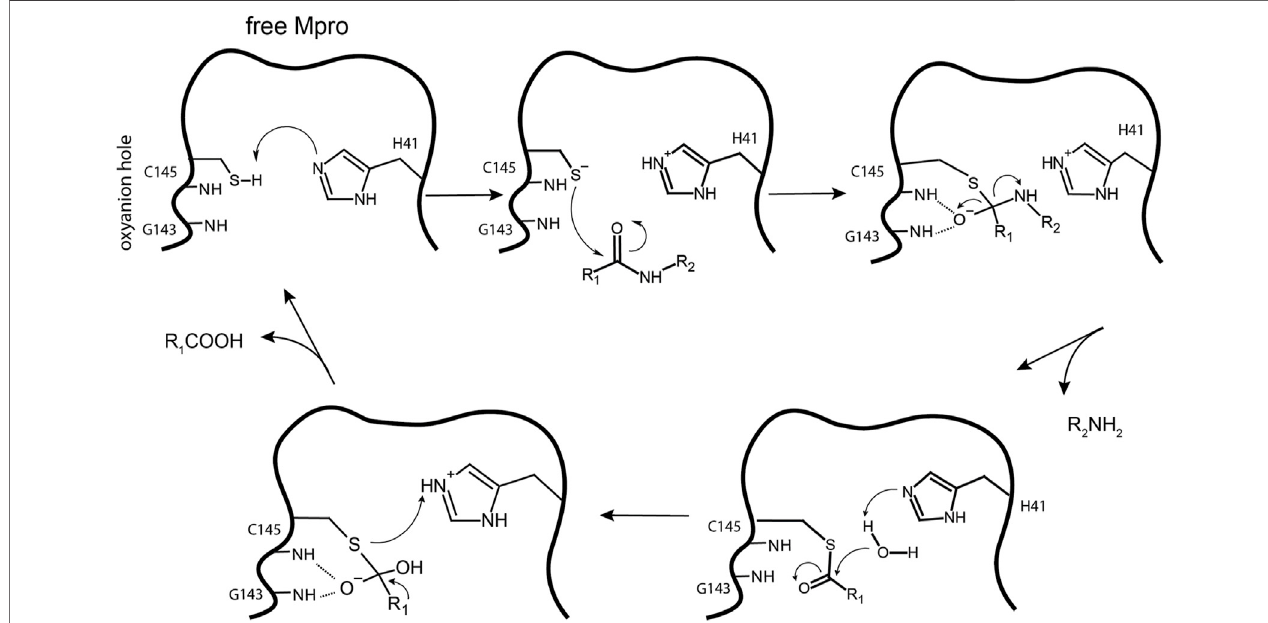
FIGURE10| HydrolysismechanismofSARS-CoV-2Mpro.Inthefreestate,H41ofMprodeprotonatesthethiolofC145.Thenextstepisnucleophilicattackbythe deprotonated C145 sulfur on the peptide carbonyl carbon. Then, a fragment of the substrate (R2) is released, and the histidine is restored to its deprotonated form. The new carboxyl-moiety undergoes nucleophilic attack by water, which results in H41 becoming protonated. The thioester bond is subsequently hydrolyzed to generate a C-terminus on the remaining substrate fragment while regenerating the free enzyme.